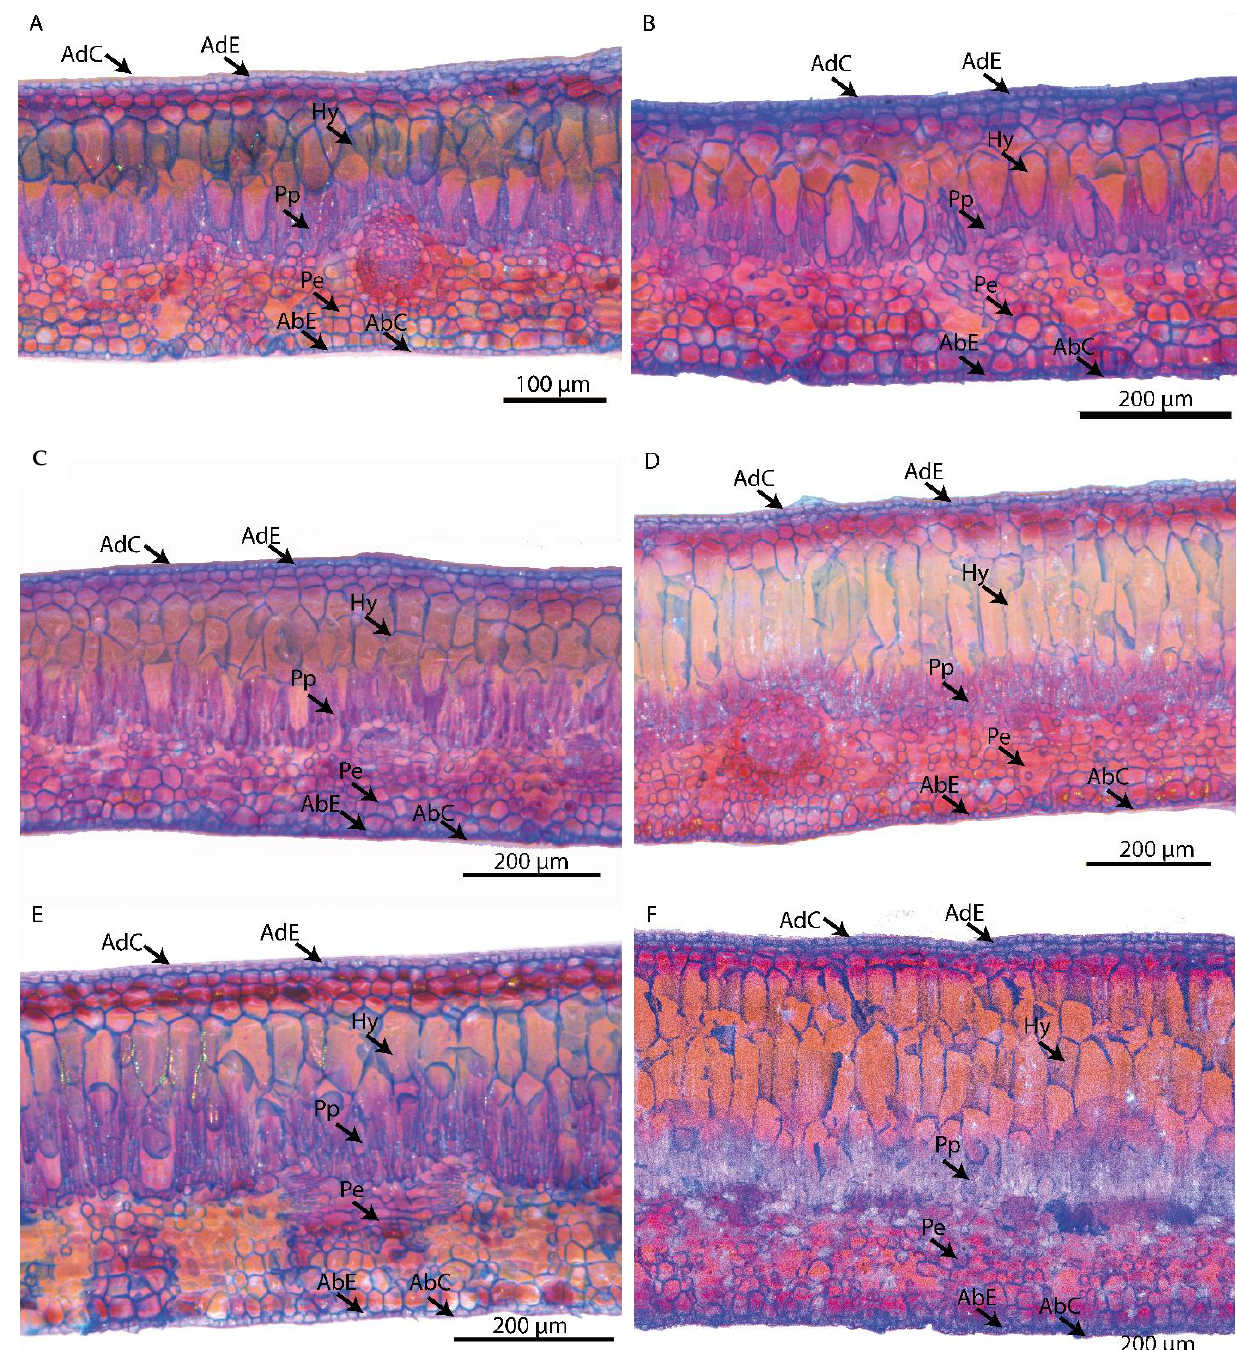
Figure 4. Histology cuts in the leaf blade of juveniles and adults of R. mangle . ( A ) SC + AD. ( B ) SC + JV. ( C ) SB + AD. ( D ) SB + JV. ( E ) OP + AD. ( F ) OP + JV. AdC = Adaxial cuticle; AdE = Adaxial epidermis; Hy = Hypodermis; Pp = Palisade parenchyma; Sp = Spongy parenchyma; AbE = Adaxial epidermis; AbC = Abaxial cuticle.